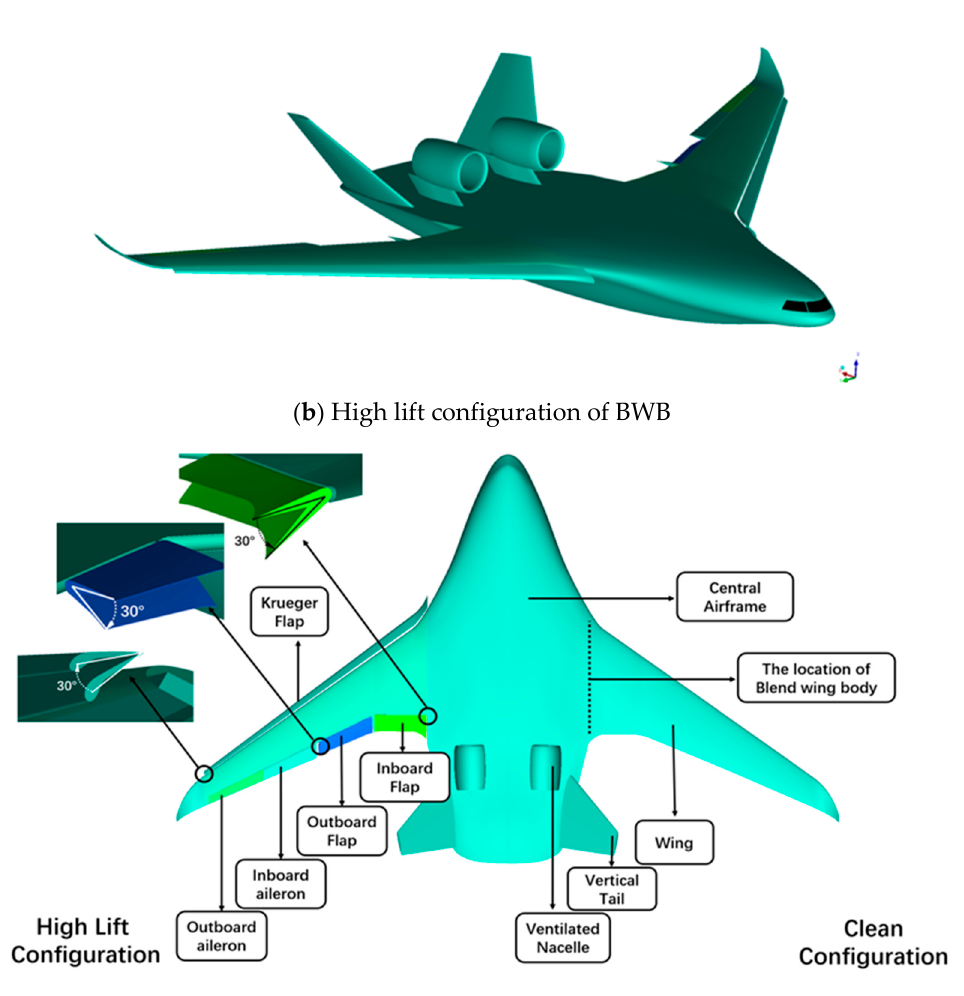
Figure 1. Definition of the configurations of BWB.